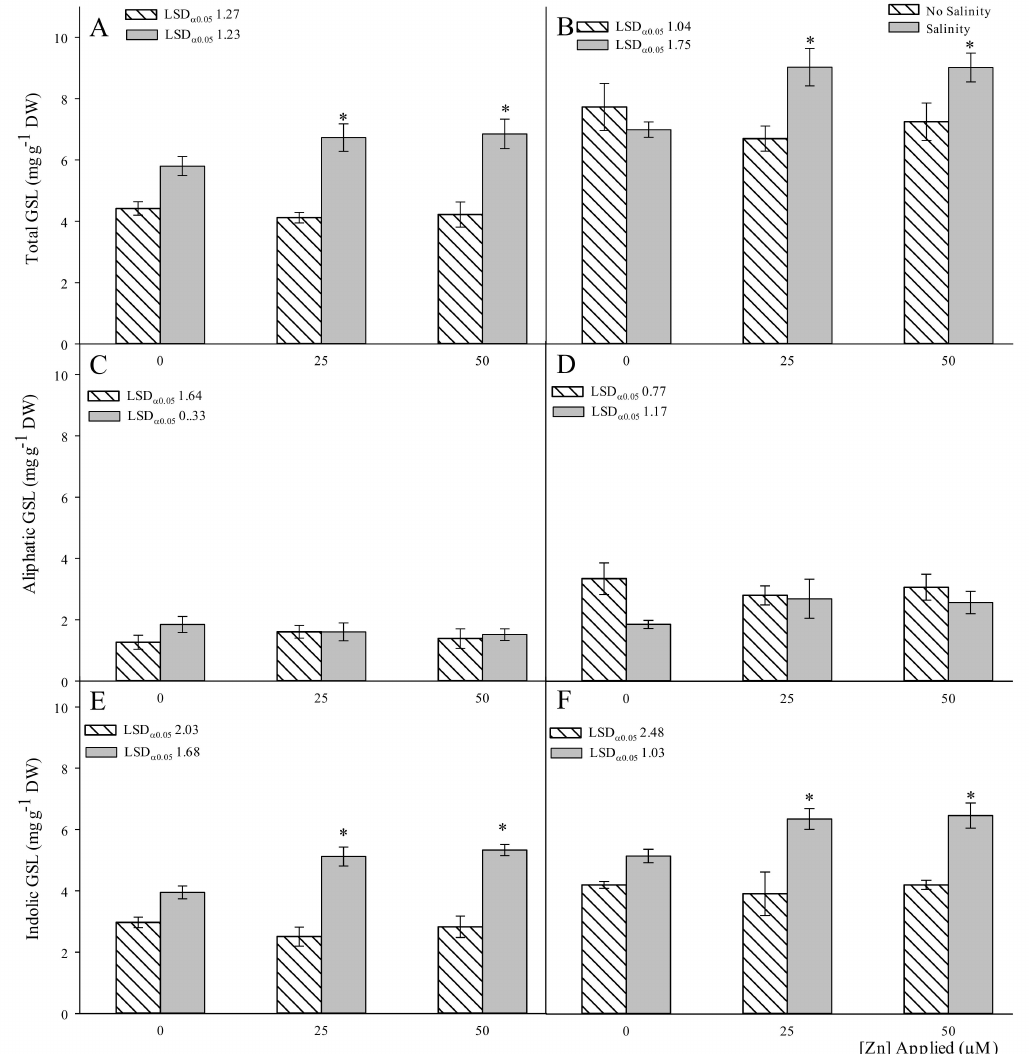
Figure 6. Glucosinolates concentrations in pak choi plants after Zn foliar application with / without salinity conditions. ( A , C , E ) Total, aliphatic and indolic concentration in pak choi leaves. ( B , D , F ) Total, aliphatic and indolic concentration in pak choi roots. GSLs concentrations are expressed as mg g − 1 DW. Values are means ± SE ( n = 3) and (*) represent statistically significant increase compared to